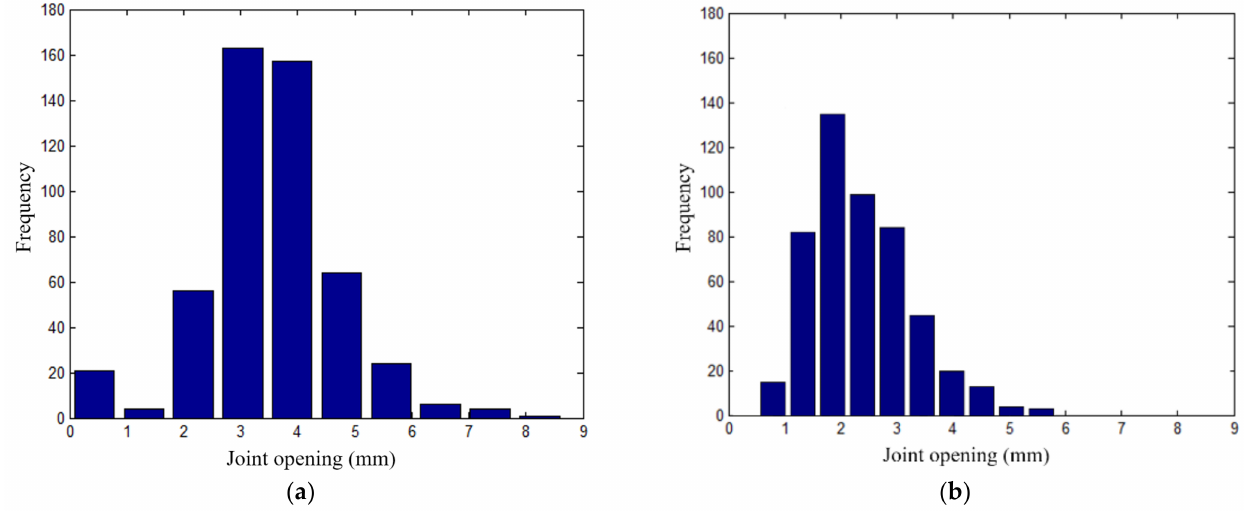
Figure 16. Error frequency distribution of the maximum joint openings in each ring after optimization of the assembly measures. ( a ) Maximum circumferential joint opening; ( b ) Maximum longitudinal joint